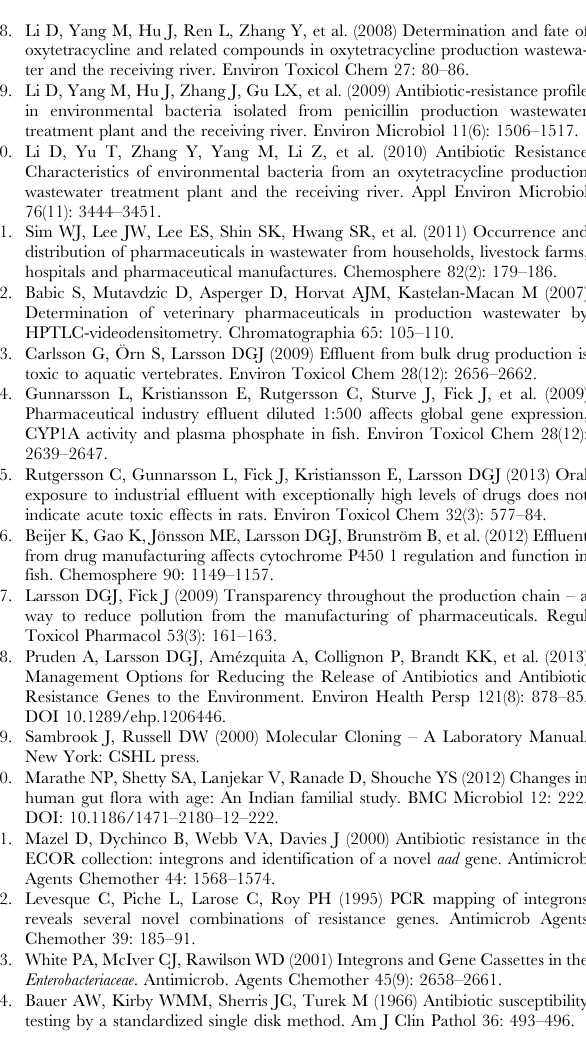
Figure S1 Melting curves obtained in qPCR analysis. A) Melting curves for 16S rRNA gene, B) Melting curves for class 1 integrase gene, C) Melting curves for class 2 integrase gene. (TIF) Table S1 The cut off values of zones of inhibition used for determination of resistant, intermediately resistant or sensitive nature of the isolated strains. Table S2 Prevalence of class 1 and class 2 integrons among the strains from the PETL